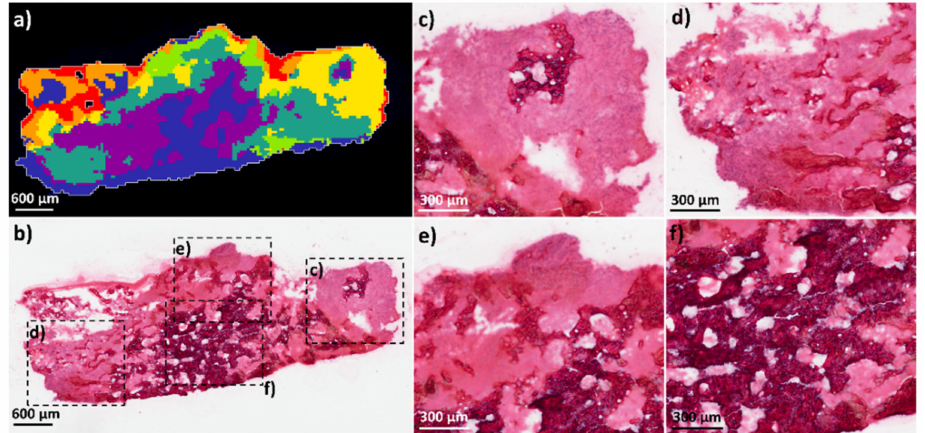
Figure 5. Spatial segmentation analysis of OS patient_826 tissue sample from metabolite data by DESI-MSI. ( a ) spatial segmentation of OS section highlighting heterogeneous clusters throughout tissue. Scale bar 600 µ m. ( b ) H&E of same OS tissue section after image analysis. Scale bar 600 µ m. Magnification of ROIs: ( c ) solid tumour (corresponding to the yellow cluster) with osteoid island (corresponding to the purple/blue clusters) at the right of the tissue; ( d ) region of tumour and mineralised bone located to the left of tissue (corresponding to the yellow and sage green clusters); ( e ) tumour and mineralised bone located at the top of the tissue (corresponding to the sage green cluster); ( f ) Dense osteoid bone present focally (purple/blue cluster). Scale bar 300 µ